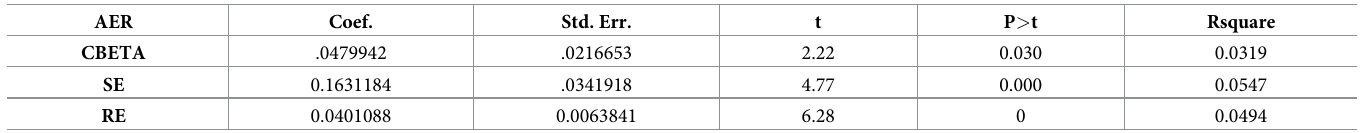
Table 7. Comparison of three models with R 2 approach.